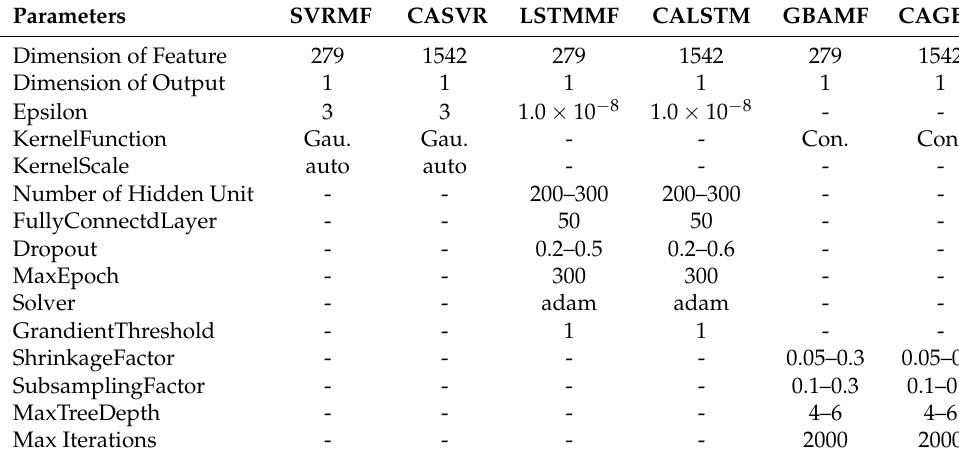
Table 1. The core parameters used in the proposed and conventional methods were summarized using the RRSYNTH